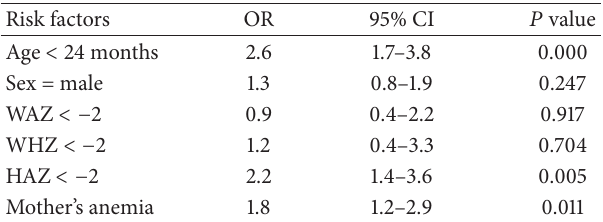
Table 1: Risk factors associated with childhood anemia in